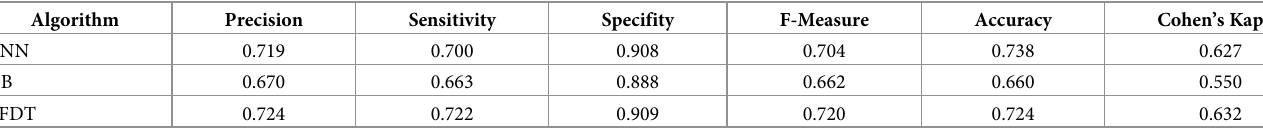
Table 4. Model prediction performance. Algorithm